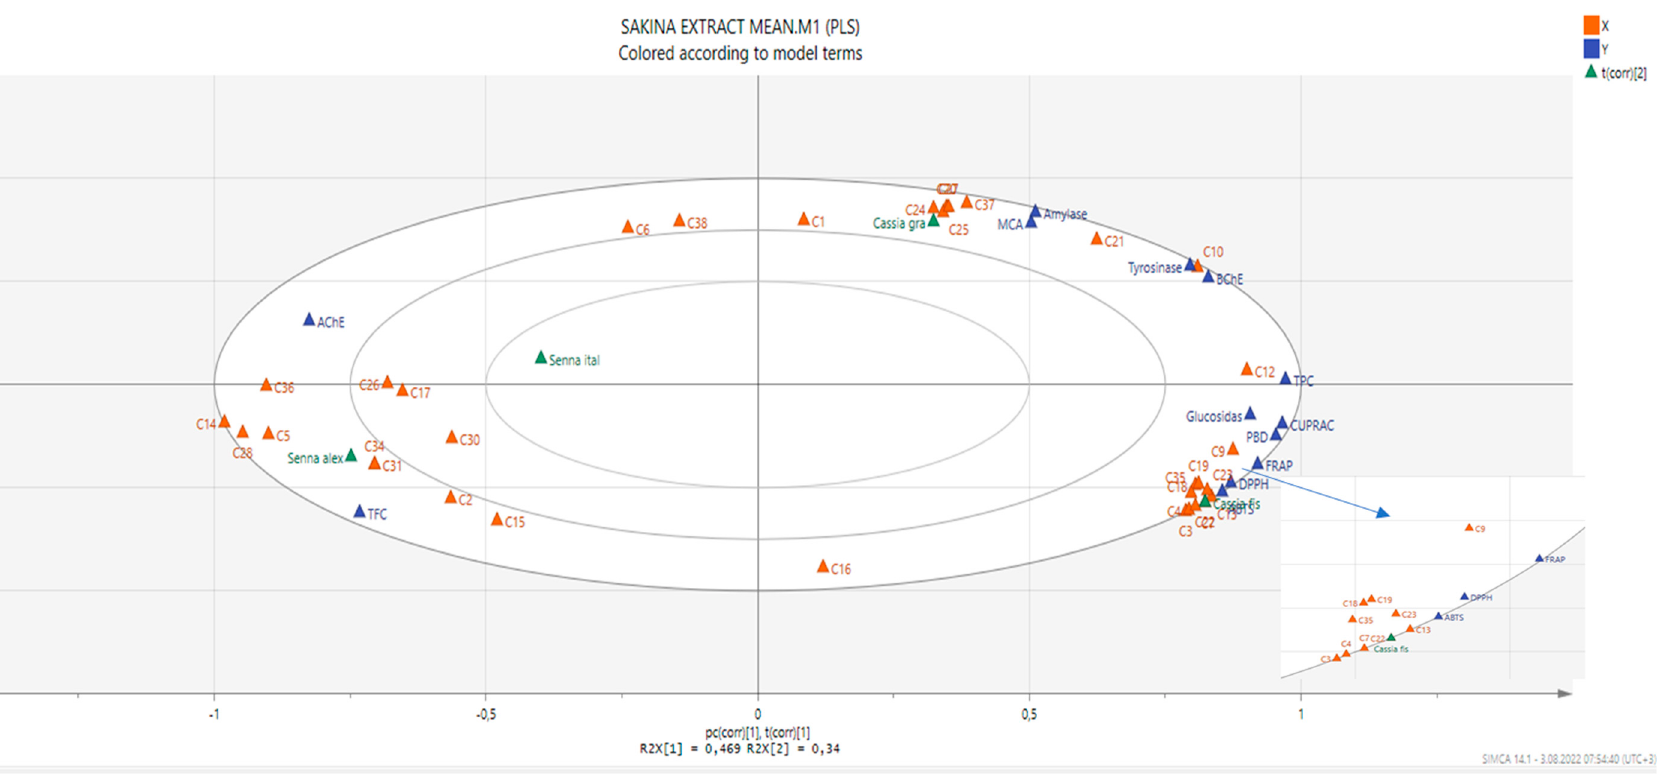
Figure 2. The biplot obtained from partial least squares regression describing the relationship between chemical compounds and bioactivities. For compound numbers refer to Table 1.